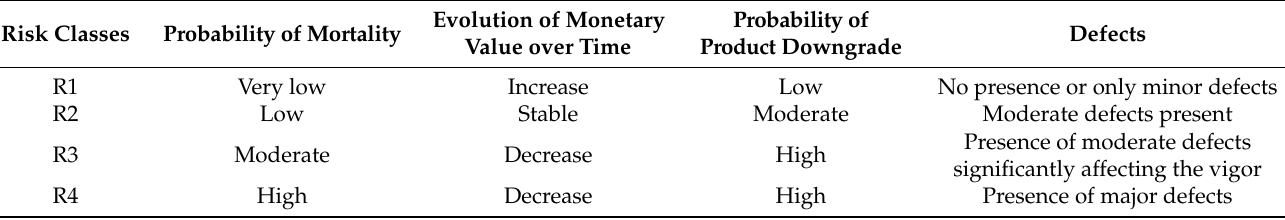
Table 3. Risk classes of trees according to tree form and risk classification